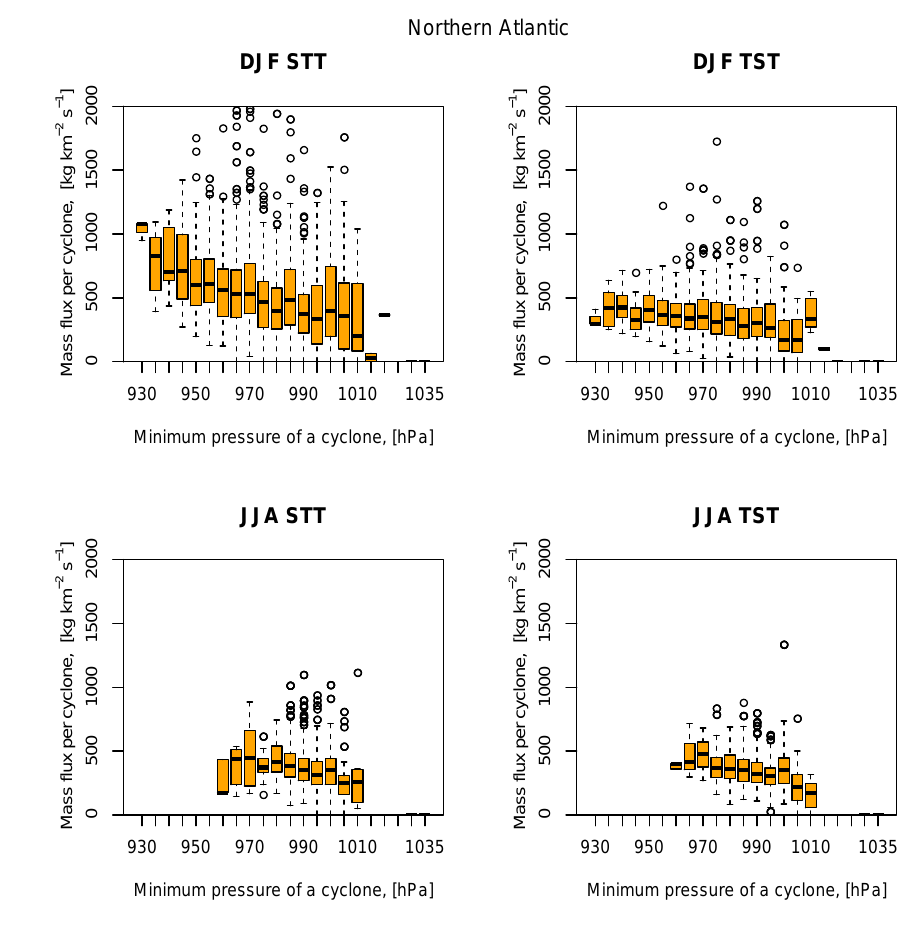
Figure 8. As Fig. 7 but for mass flux (kgkm − 2 s − 1 ).